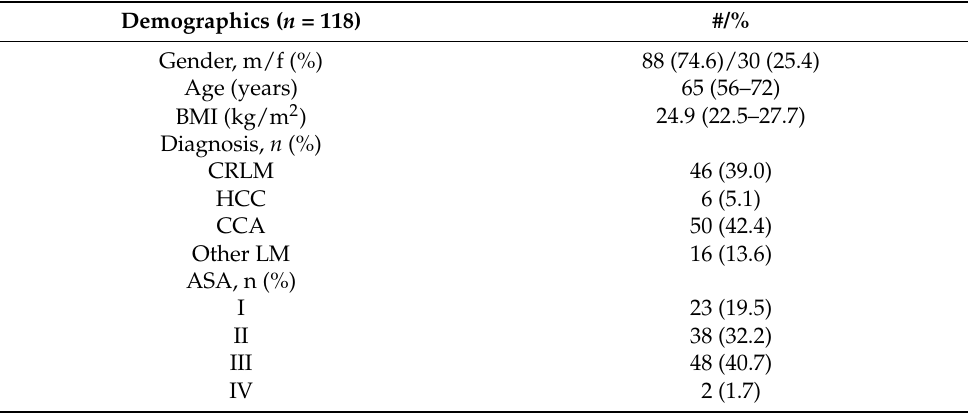
Table 1. Clinical characteristics pre- and